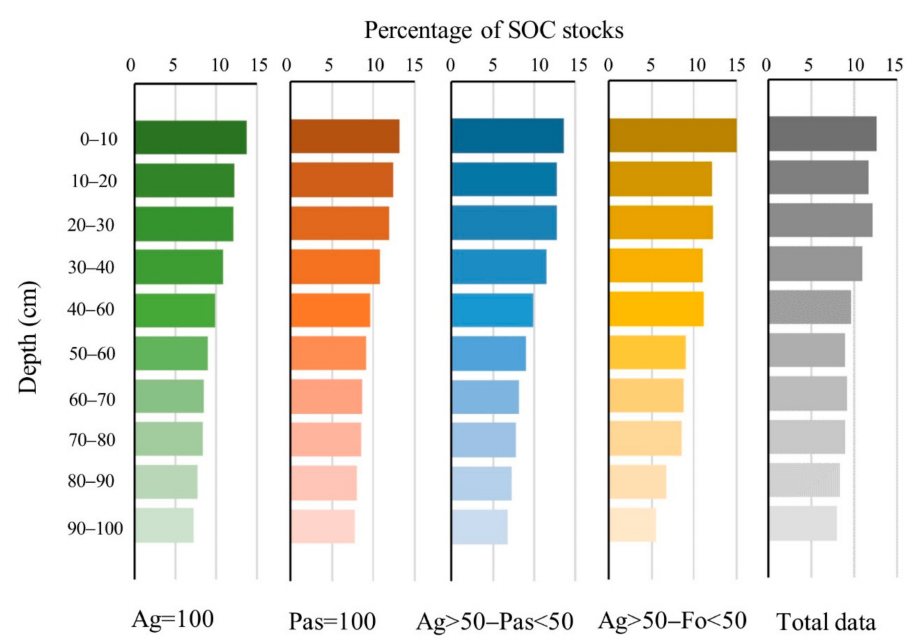
Figure 3. The percentage of SOC stocks at the entire soil profile of each LULC history